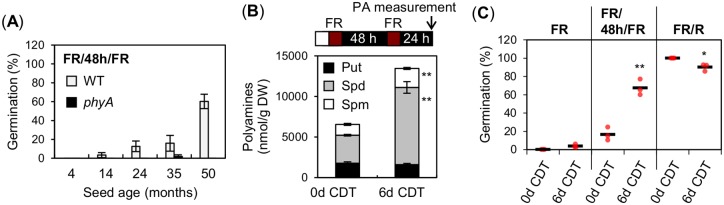
Seeds undergoing controlled deterioration treatment (CDT) increase PA levels and enhance phyA-mediated seed germination.(A) Histograms show germination percentages with WT and phyA seeds of different ages exposed to a FR/48h/FR assay. Three technical repetitions of the germination percentage of 50–65 seeds were used for SD. (B) Free PA (Put, Spd and Spm) levels in CDT-exposed WT seeds exposed to a FR/48h/FR assay. PA levels were measured 24 h after the second FR pulse. Three technical repetitions were used. (C) Germination percentages of WT seeds shown in (B) after exposure to a FR, FR/48h/FR or FR/R assay. For each repetition, the germination percentage of 50–65 seeds is shown by a red dot. The average germination percentage for the three repetitions is represented by a horizontal black bar. Statistical treatment as in Fig 1B. Experiments in (B) and (C) were repeated with two biological seed batch samples, which provided similar results (S7B, S8B and S8C Figs).